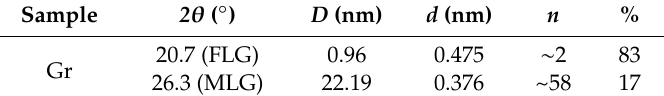
Table 1. Structural parameters obtained from the XRD pattern.